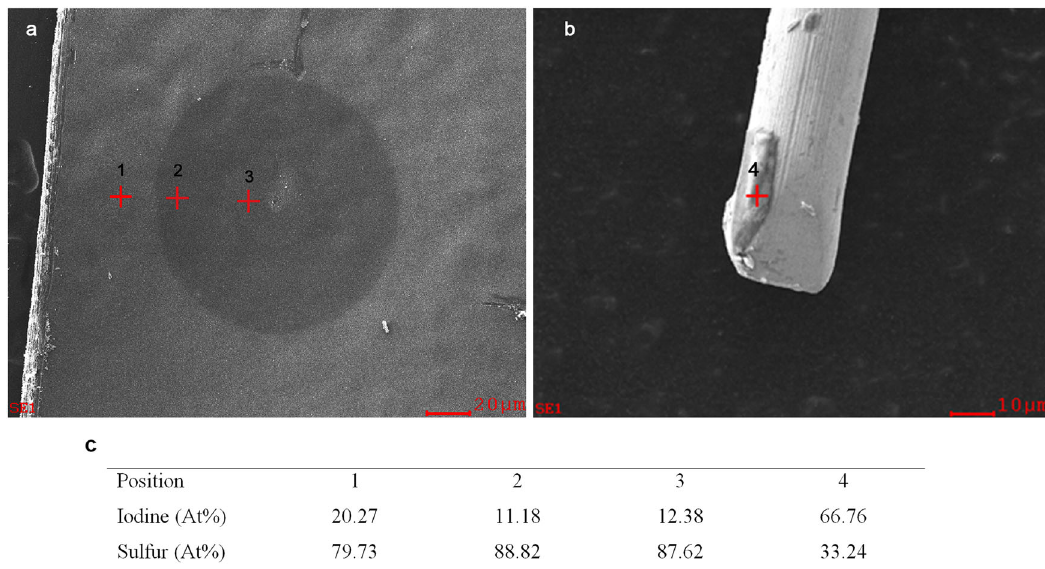
Fig. 5 EDX point-scan analysis of (BEDO-TTF) 2.4 I 3 fi lm and the platinum electrode after positive bias application. a (BEDO-TTF) 2.4 I 3 fi lm and b Pt electrode SEM images. The red plus sign indicates the EDX point-scan areas. c Tabulated experimental data of the atomic percentage of iodine and sulfur content at the four